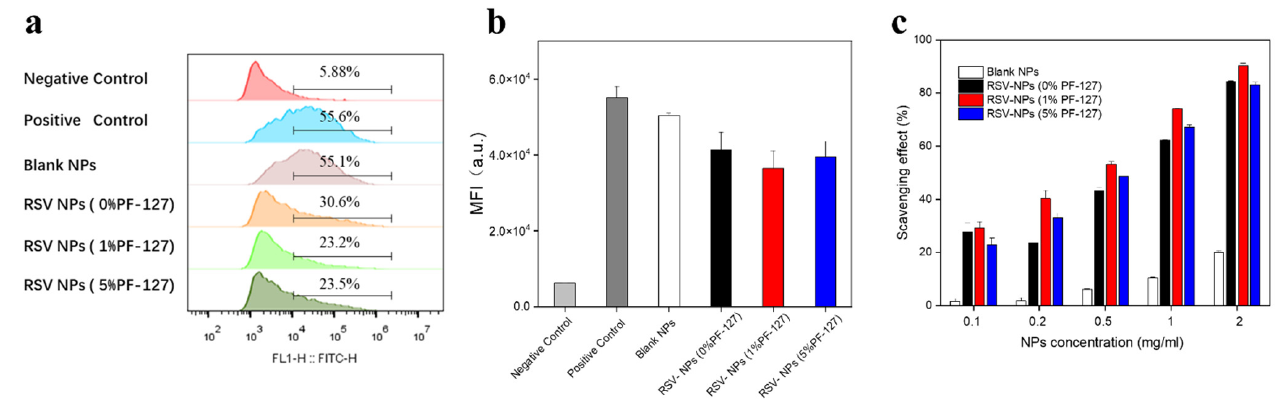
Figure 5. In vitro antioxidant activities of NPs. ( a ) Flow cytometric histograms of RAW 264.7 macrophages determined by DCFH-DA staining after treatment of various NPs. ( b ) MFIs of RAW 264.7 macrophages treated with various NPs showing intracellular ROS signals. ( c ) The radical scavenging activity of various NPs by the DPPH assay. Each point represents the mean ± S.E.M. ( n = 3).